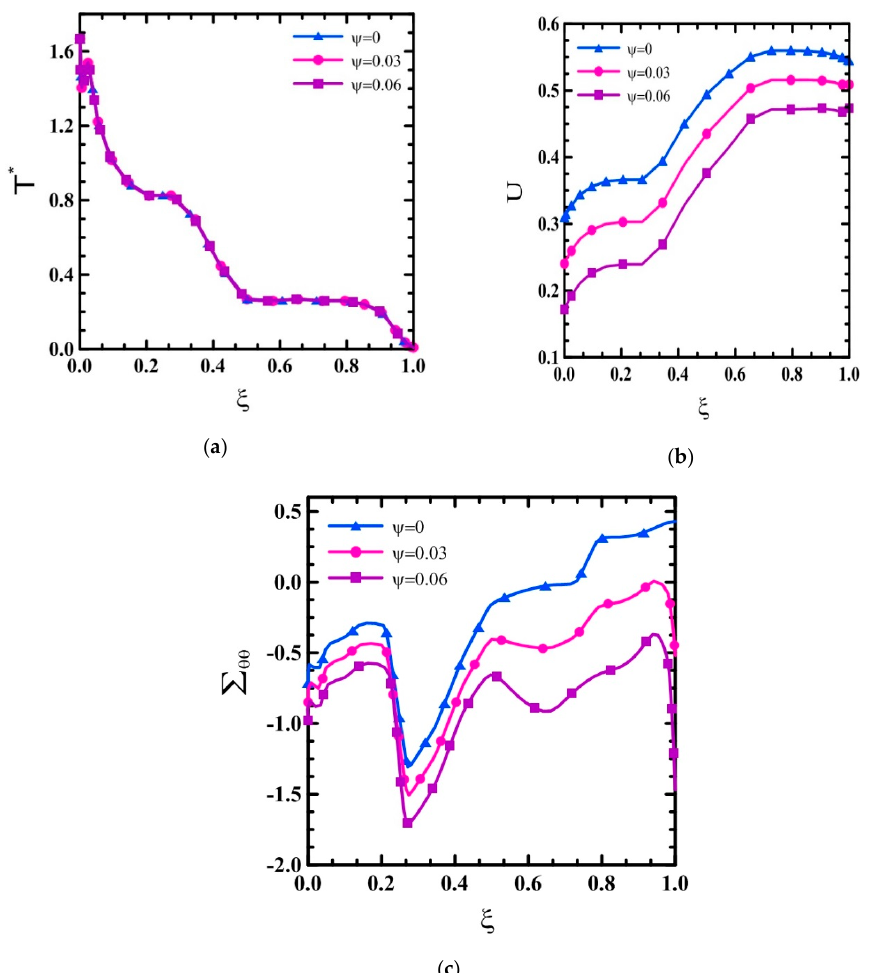
ψ Figure 13. ( a – c ): Effect of the external electrical voltage on the distribution of the thermoelastic Figure 13. ( a – c ): E ff ect of the external electrical voltage ψ on the distribution of the thermoelastic field ( (cid:16) (cid:17) Appl. Sci. 2020 , 10 , x FOR PEER REVIEW = n = 1, h c / h p = 5, θ = 0.5 θ 0 , F 0 = 0.8, τ = 0.2 variables in the radial direction . field variables in the radial direction